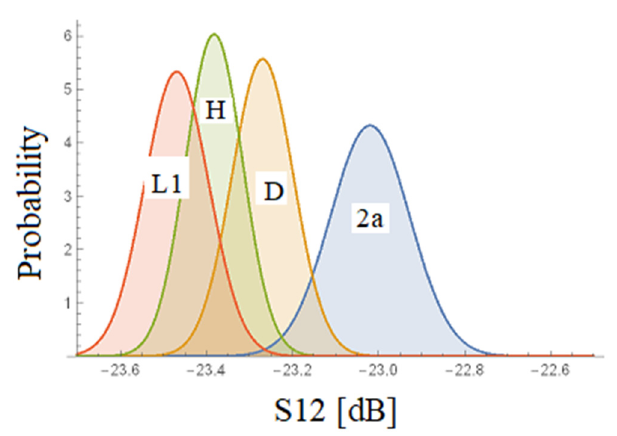
Figure 14. The S12 magnitude of the master diamonds in a bell-shaped graph at a frequency of 26.025 GHz.